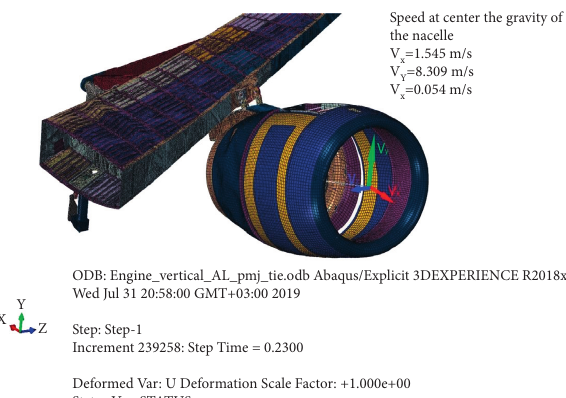
Figure 23: Deformation after emergency break—vertical